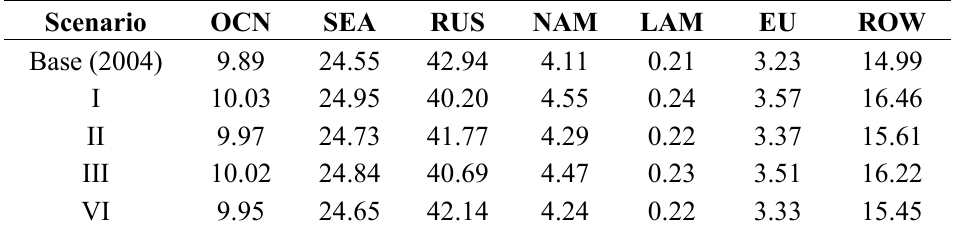
Table 7. Shares (%) in China’s import